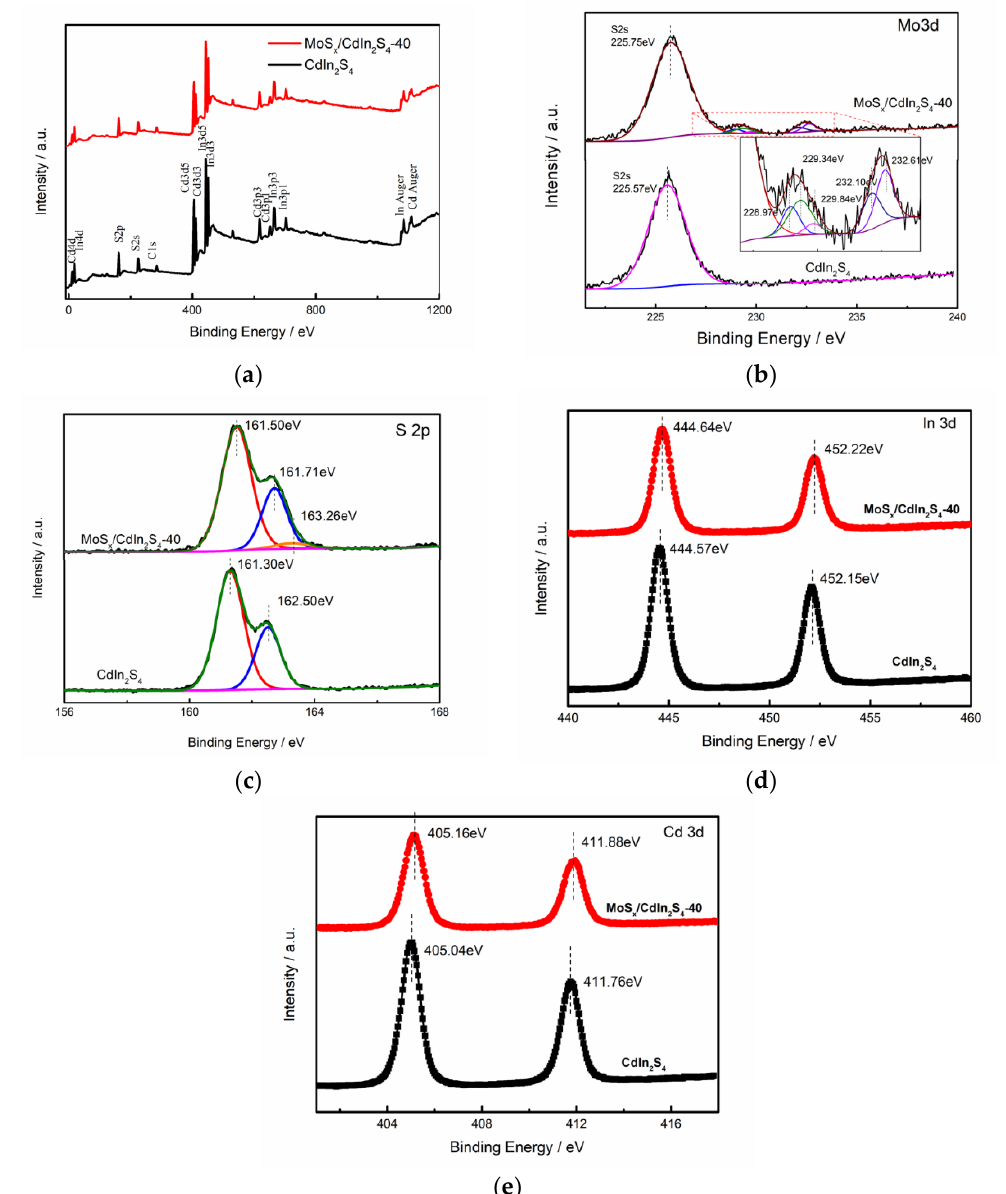
Figure 3. X-ray photoelectron spectrcopy (XPS) spectra of CdIn 2 S 4 and MoS x / CdIn 2 S 4 . Survey spectra ( a ); high-resolution spectra of Cd ( b ); In ( c ); Mo ( d ); and S ( e ).